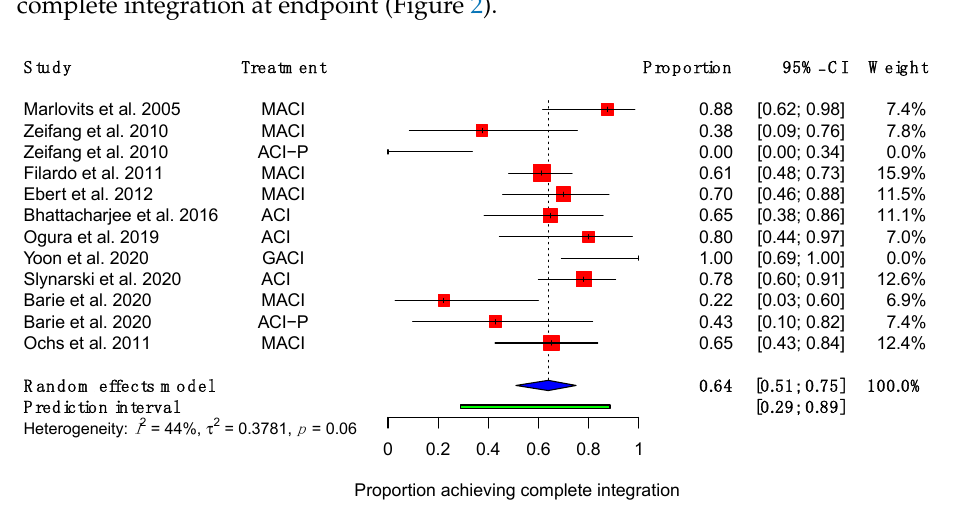
Figure 3. Forest plot on the improvement in mean integration score during follow-up after receiving therapy with a cell-seeded scaffold. (Abbreviations: MACI, Matrix-induced autologous chondrocyte implantation; MAMI, Matrix-induced autologous mesenchymal stem cell implantation; Acc., accel- erated; FWB, full weight-bearing; SMD, standardized mean difference; CI, Confidence Intervals).